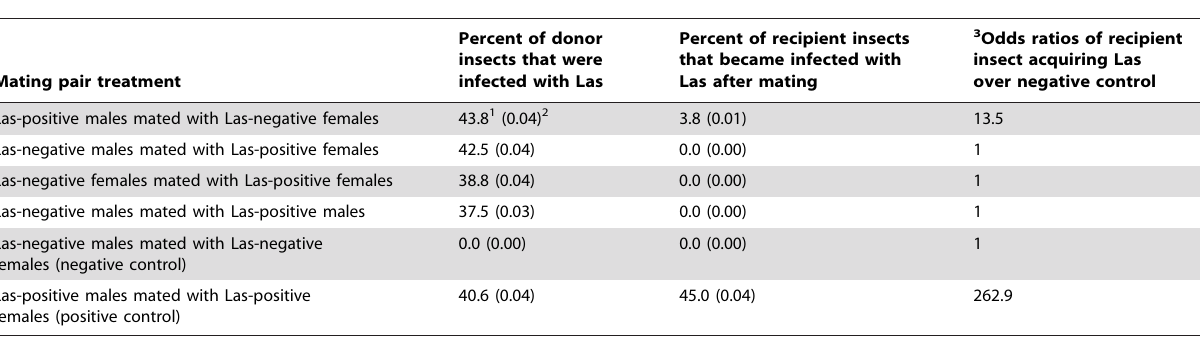
Table 1. Venereal transmission of Las between adult D. citri .